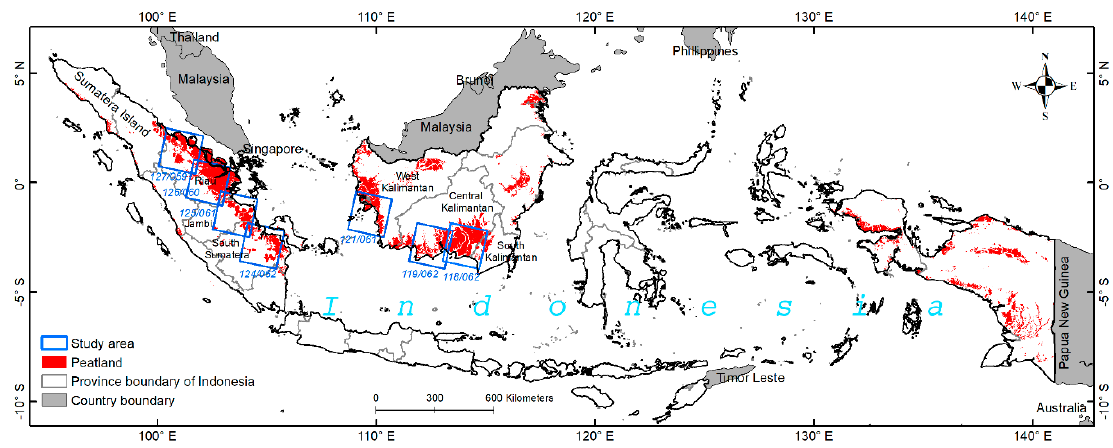
Figure 2. Study areas (blue trapezoid) coverage of Landsat-8 scene areas (path / row of 118 / 062, 119 / 06, 121 / 061, 124 / 062, 125 / 061, 126 / 060, 127 / 059) over Kalimantan and Sumatera’s peatland (in red). Peatland data sources from the Indonesian Ministry of Agriculture (2011). Administration boundaries are from Geospatial Information Agency of Indonesia. Table 3. List of Landsat-8 data for applying and assessing Tropical Peatland Combustion Algorithm (ToPeCAl) without TIR (ToPeCAl-2) in Central Kalimantan, South Kalimantan, West Kalimantan, Riau, Jambi, and South Sumatera. Study Area Landsat-8 (cid:48) s Path / Row